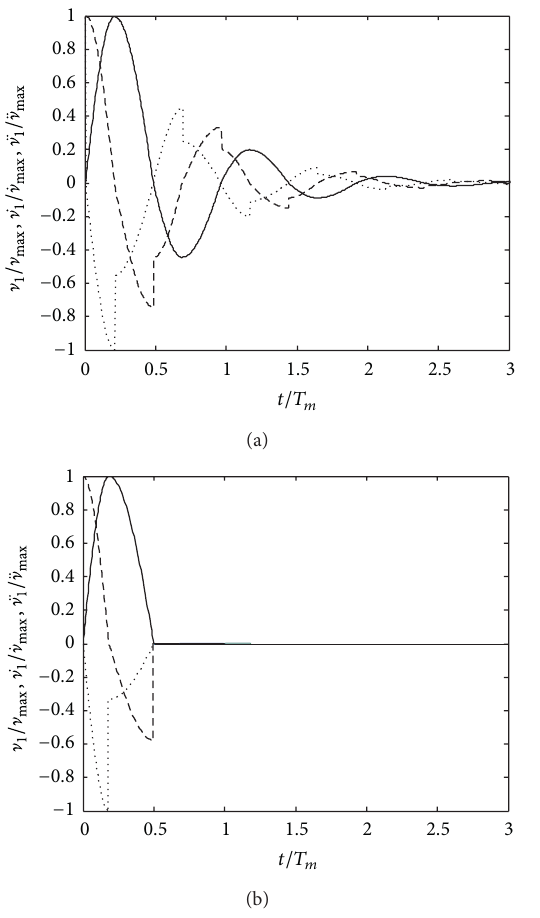
Figure 8: Time response for the impacting model. The time is normalised with respect to the mean period 𝑇 𝑚 . (a) 𝜎 = 0.5 and 𝜇 = 0.1 , (b) 𝜎 = 0.75 and 𝜇 = 0.25 . The frequency ratio between secondary and primary system is Ω = 3 (— displacement; - - - - velocity; ⋅⋅⋅ acceleration).